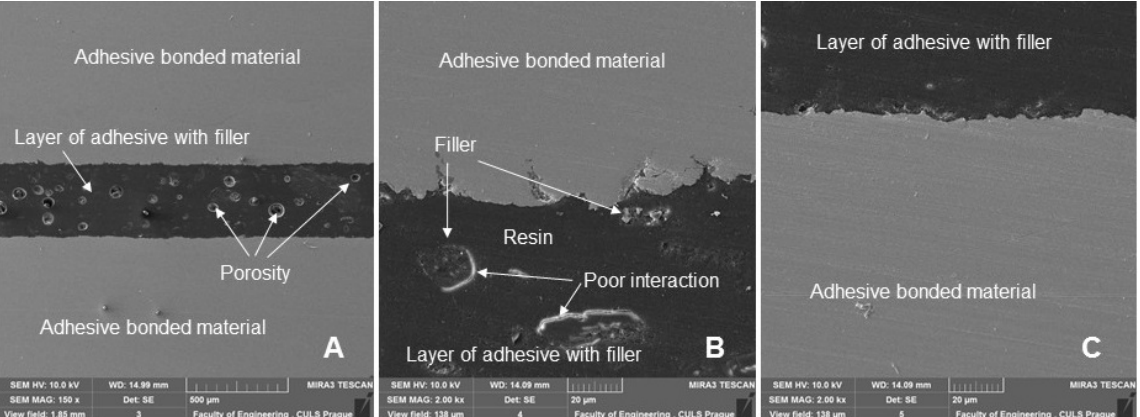
Figure 11. SEM images of an adhesive bond with a biological filler based on coconut microparticles—designation AB20, 0 cycles: ( A ): adhesive bond (MAG 100 × ), ( B ): adhesive bond with a detailed view of the adhesive layer and the interaction of the filler with resin (MAG 2.00 k × ), ( C ): section of the adhesive bond with a detailed view of the adhesive layer of the adhesive bond (MAG 2.00 k ×